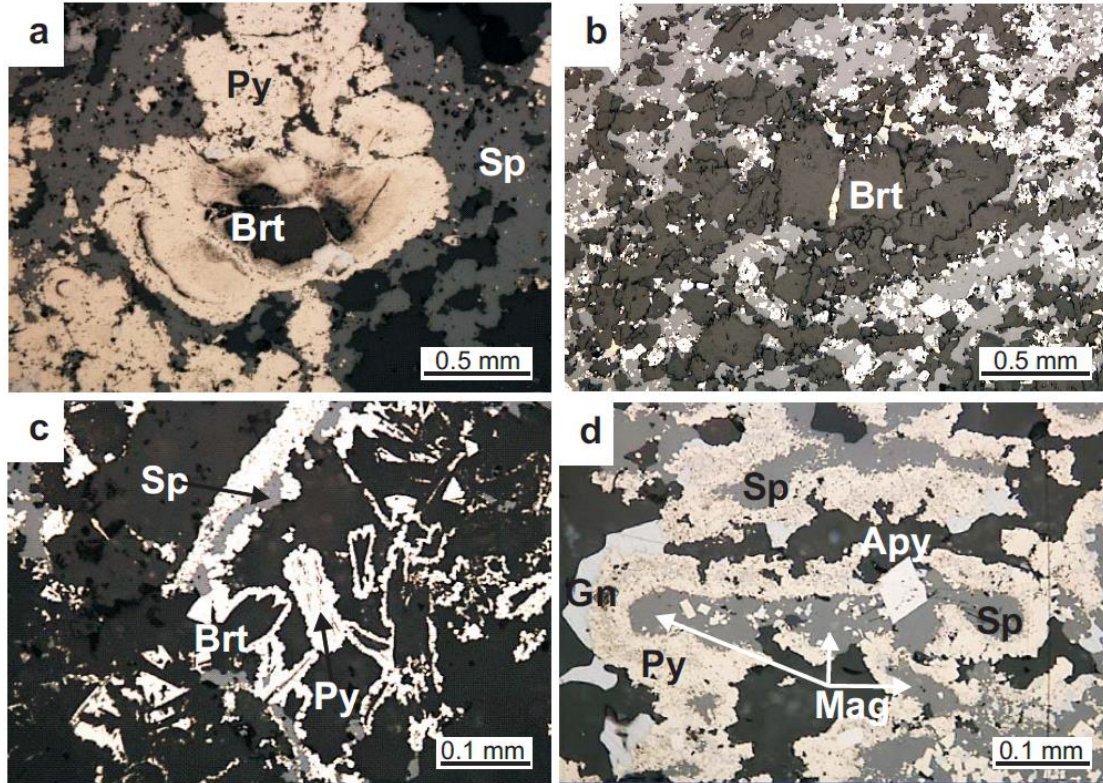
Figure 4. Optical microscope images of barite mineralizations from Magdalena deposit. ( a ) Barite (Brt) overgrown by colloform pyrite (Py), in turn, included in late sphalerite (Sp); ( b ) relicts of tabular barite crystals replaced by an association of sphalerite and fine grained pyrite; ( c ) barite laths showing pyrite rims and interstitial sphalerite; ( d ) sphalerite pseudomorph after possible barite laths rimmed by fine pyrite aggregates and galena (Gn) interstitial infillings. The idiomorphic arsenopyrite crystal (Apy) is related to a later crystallization stage.